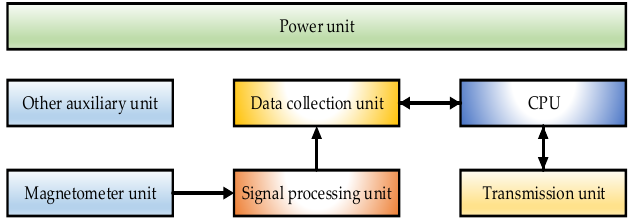
Figure 11. The block diagram of the measurement system.